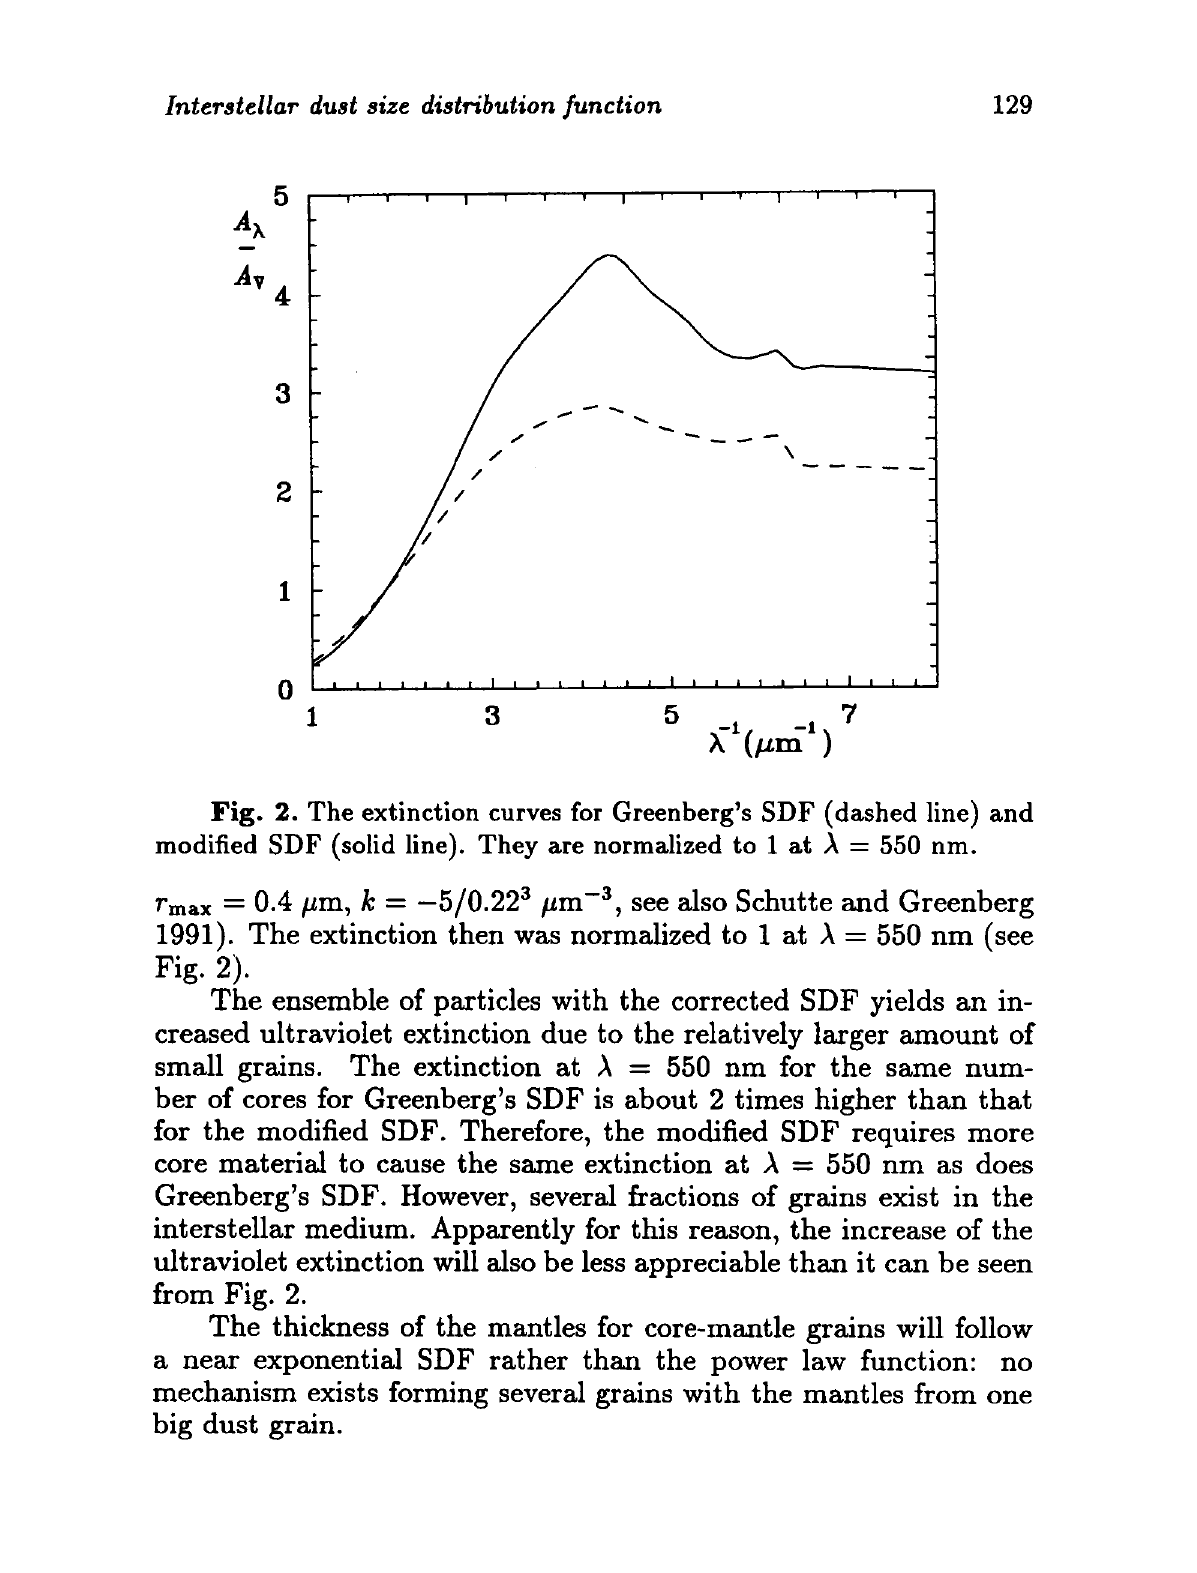
Fig. 2. The extinction curves for Greenberg's SDF (dashed line) and modified SDF (solid line). They are normalized to 1 at Λ = 550